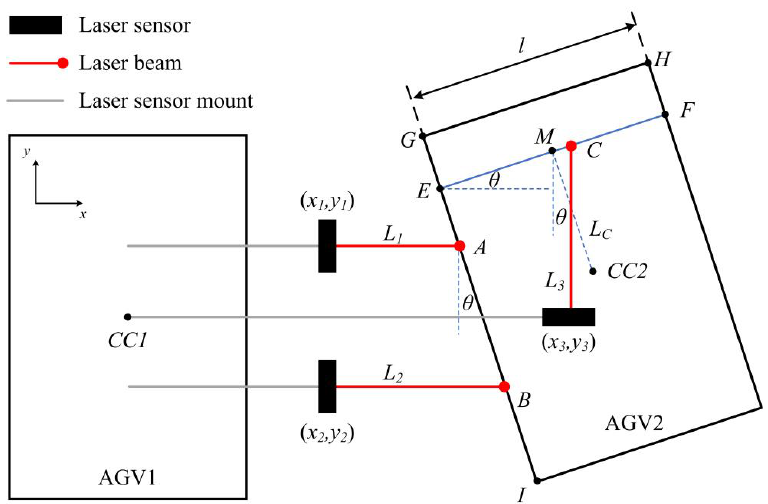
Figure 10. Experiment AGV system architecture.